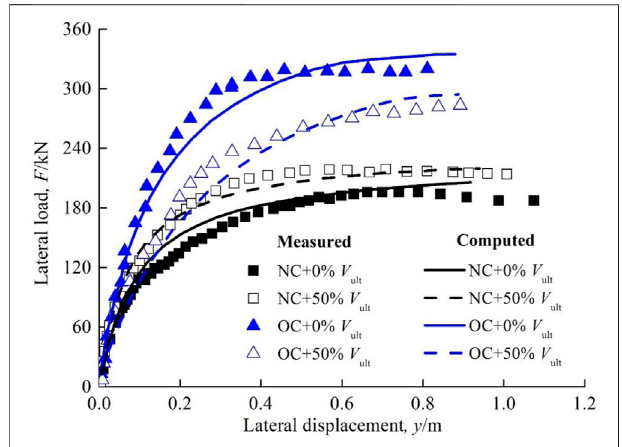
FIGURE 7 | Comparison between the measured and computed monotonic load-displacement relationships of the